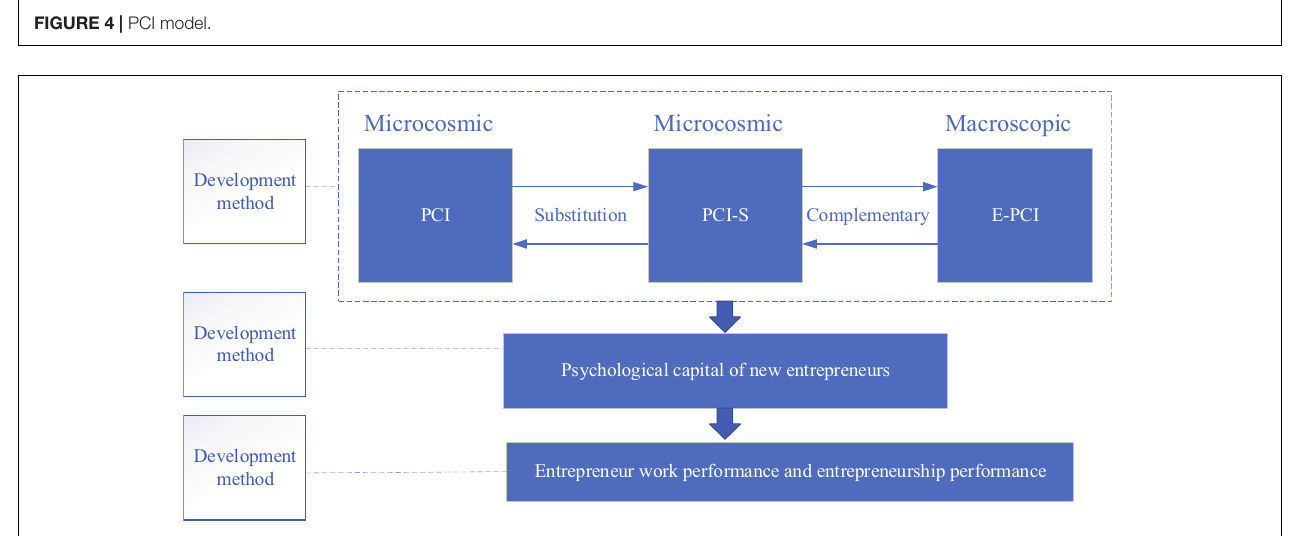
FIGURE 5 | E-PCI-S model for developing entrepreneurs’ psychological